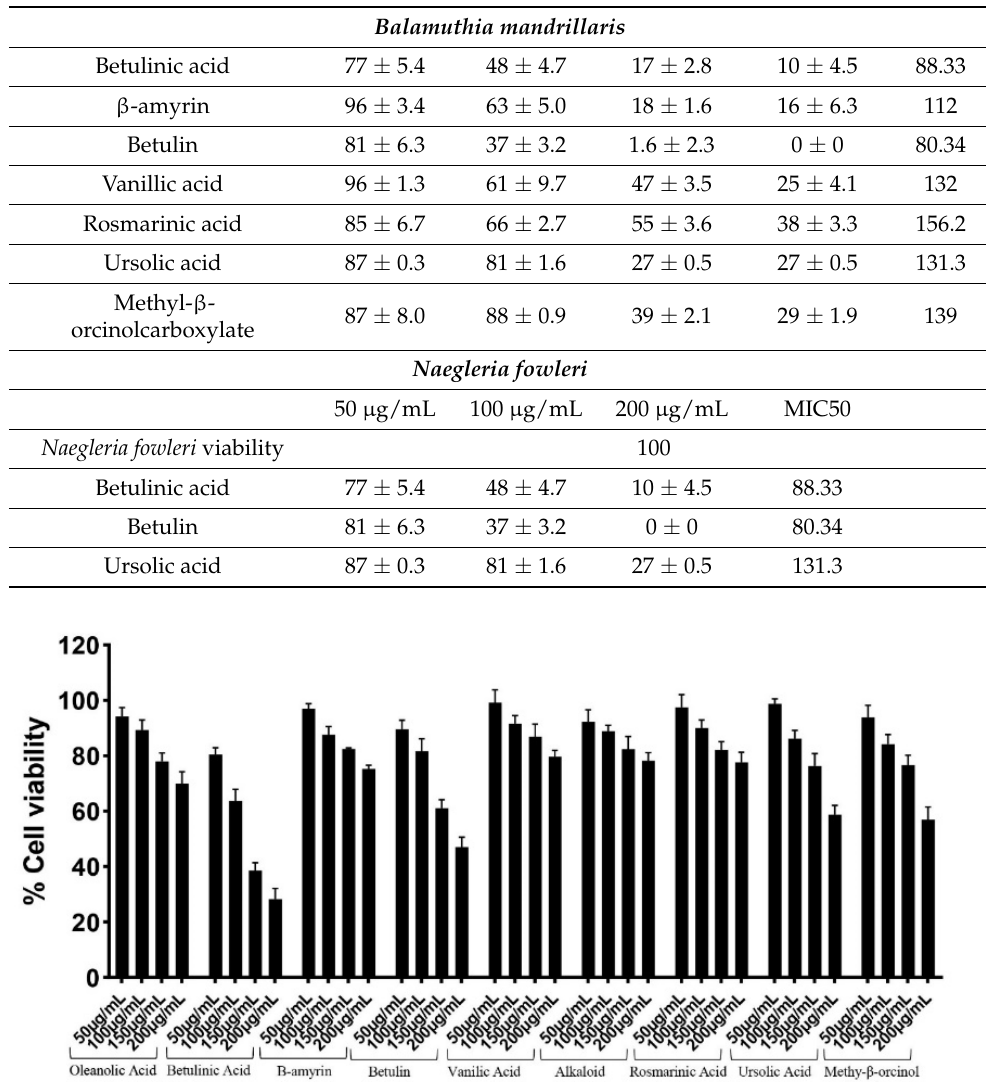
To evaluate the effect of the plant-based compounds on amoebae-mediated host cell death, cytopathogenicity assays were carried out. B. mandrillaris and N. fowleri were pre- treated with the test compounds before being introduced to the HeLa cell monolayer. The results revealed that upon the treatment of B. mandrillaris and N. fowleri, amoebae-mediated host cell death was reduced, compounds exhibiting significant amoebicidal activities, showed reduced amoeba-mediated host cell cytotoxicity (Figure